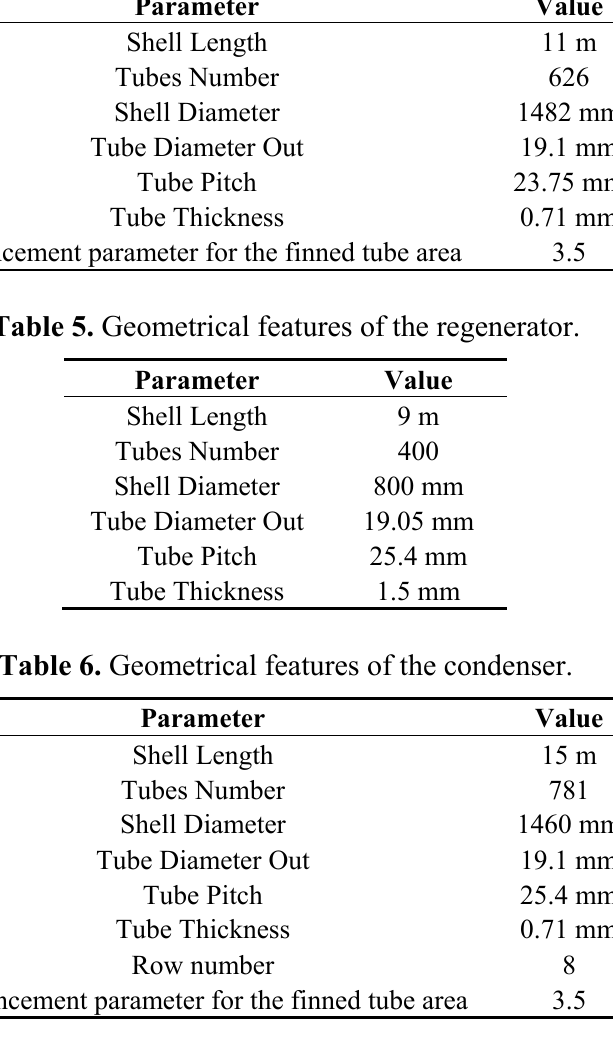
Table 7. Main parameters of the